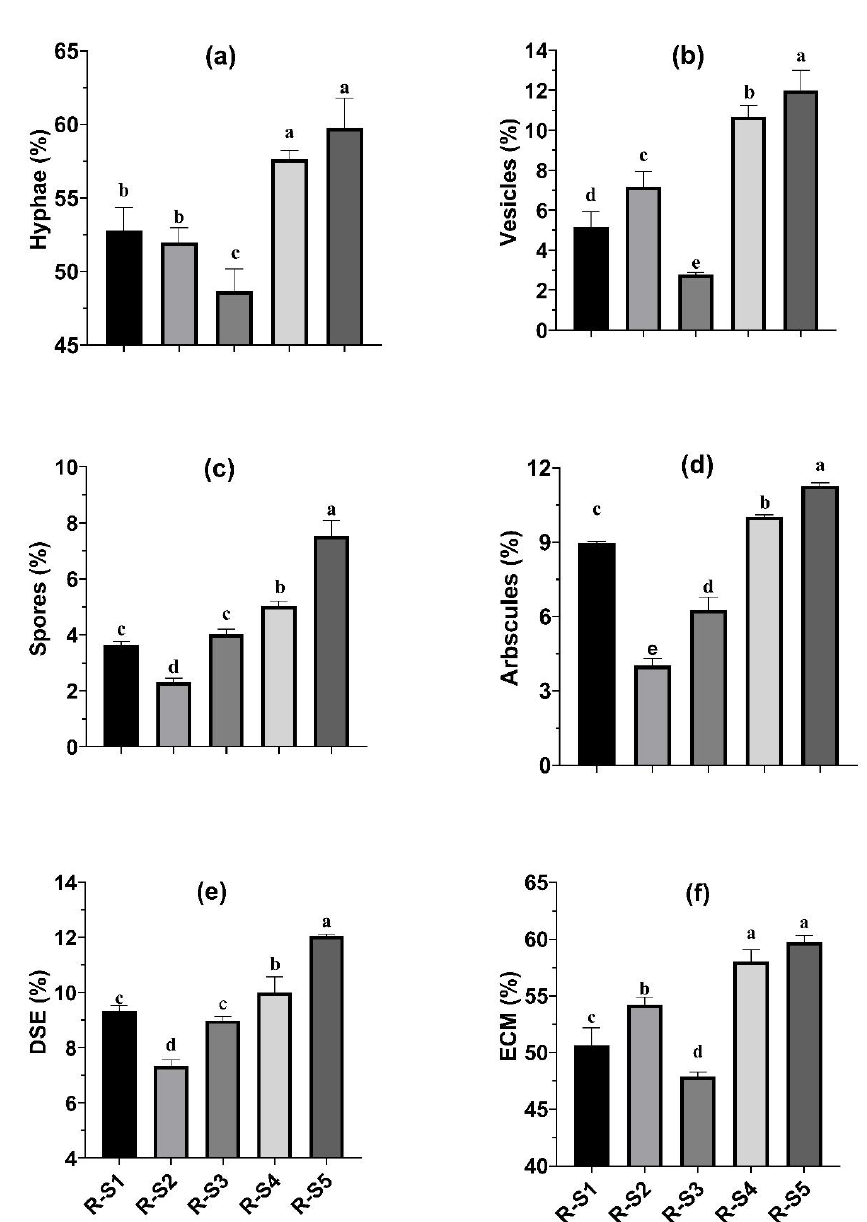
Figure 2. Hyphal ( a ), vesicles ( b ), spores ( c ), arbuscules ( d ), DSE ( e ), and ECM ( f ) colonization in the roots of Cenchrus ciliaris extracted from trap culture experiment grown in various rhizospheric soils from selected plants. Each column with a different letter is significantly different at p < 0.05. Where R-S 1 = rhizospheric soil of Typha angustata , R-S 2 = rhizospheric soil of Cymbopogon jwarancusa , R-S 3 = rhizospheric soil of Saccharum spontaneum , R-S 4 = rhizospheric soil of Setaria verticillata , R-S 5 = rhizospheric soil of Saccharum bengalense